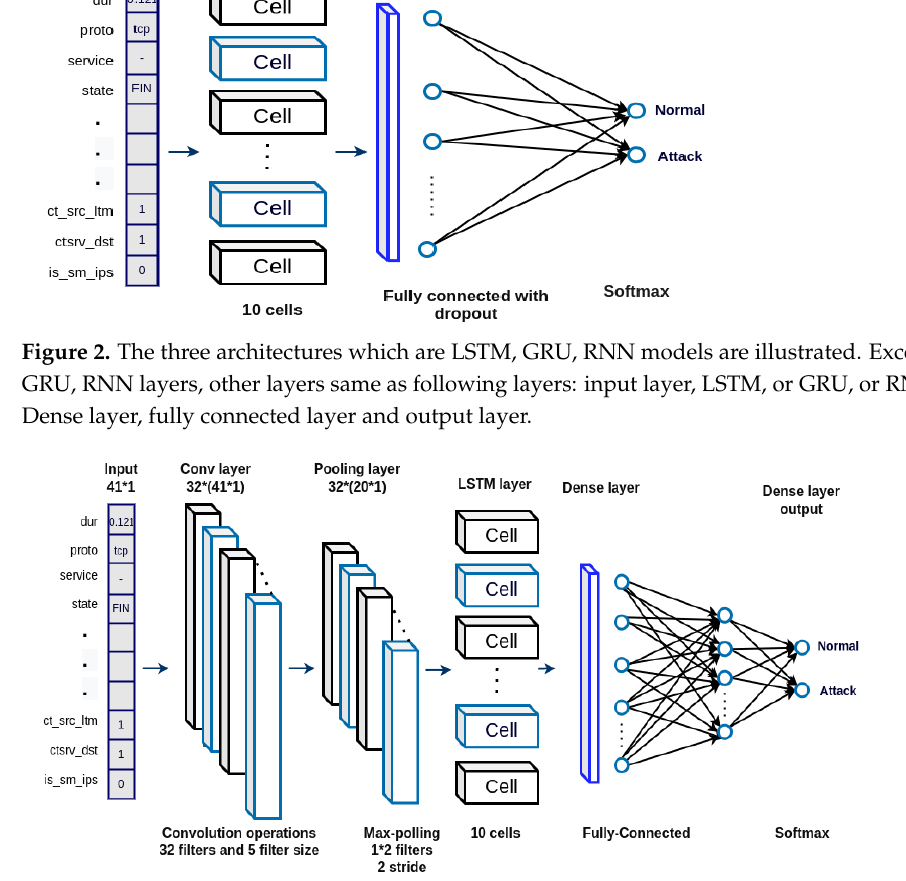
Figure 3. The architecture of the CNN and LSTM combination model. The architecture includes following layers: input layer, one convolution layer, one max-pooling layer, one LSTM layer, Dense layer, fully connected layer and output